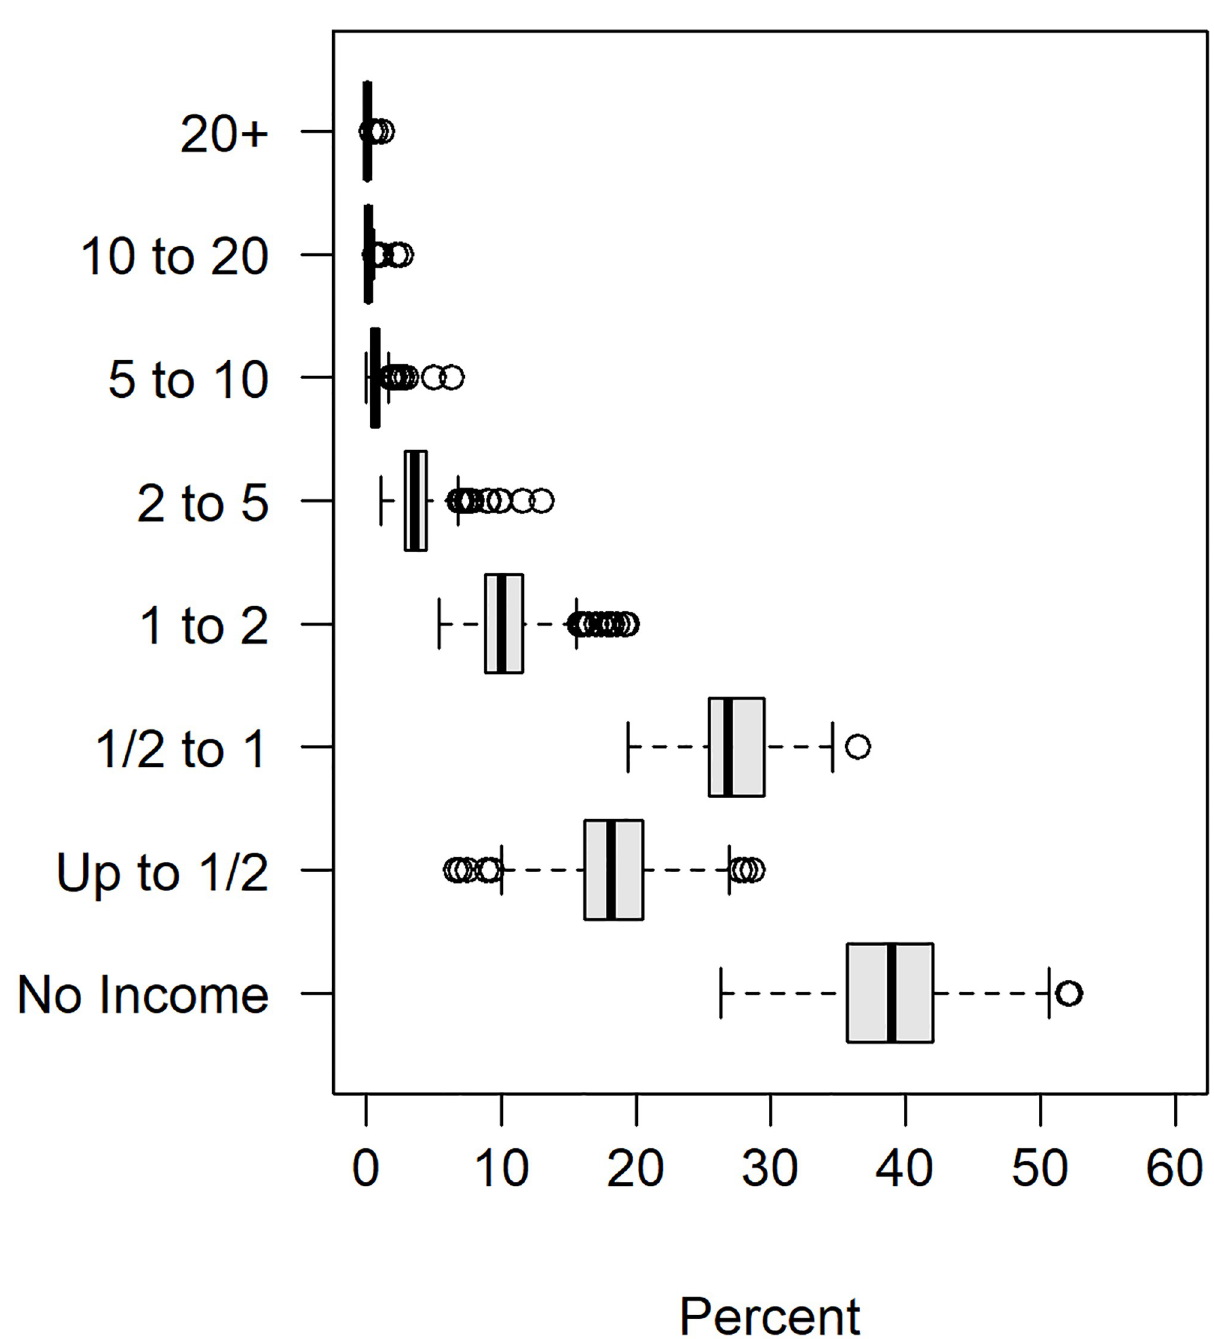
Fig 4. Distribution of percent of residents that fall within each income brackets for all RN municipalities as captured by the 2010 Brazilian Federal Census.